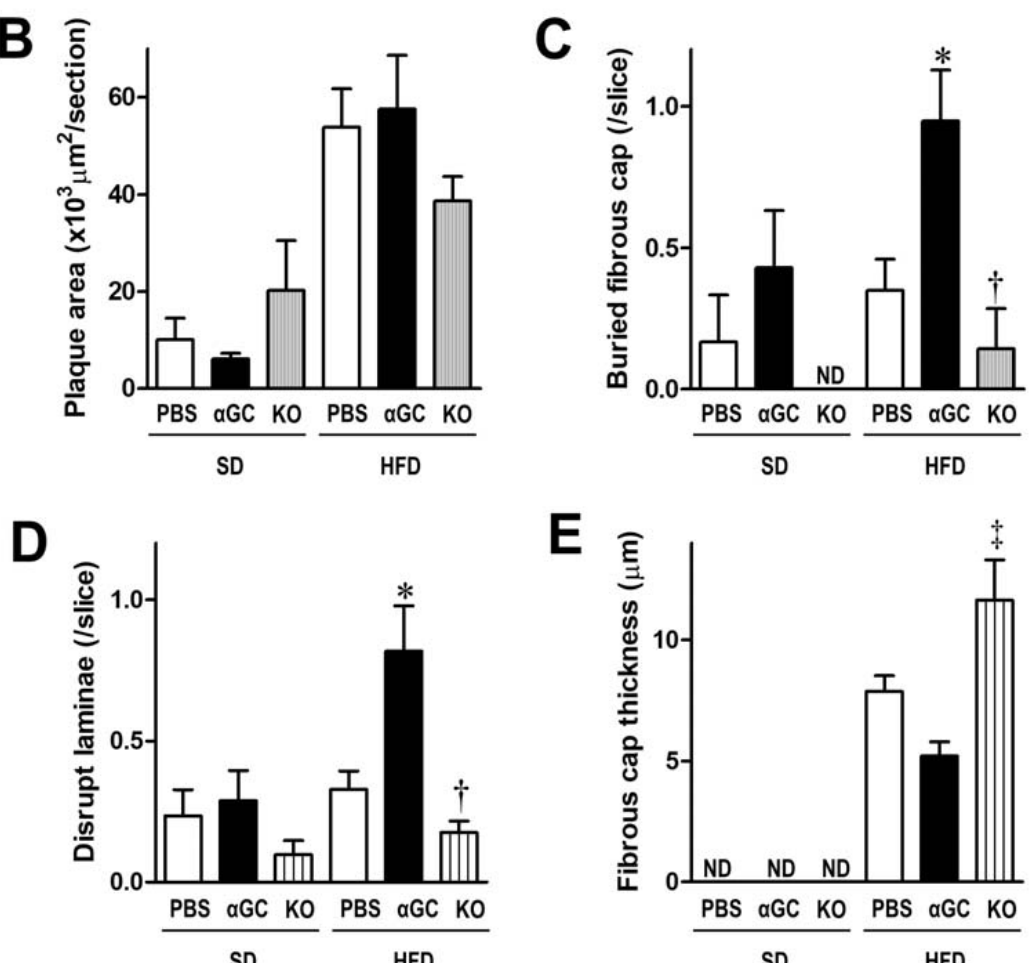
Figure 2. Histomorphometric analysis at the brachiocephalic artery from six groups of SD-PBS (n = 6), SD- α GC (n = 7), SD-KO (n = 3), HFD-PBS (n = 21), HFD- α GC (n = 21), and HFD-KO (n = 9) mice. ( A ) Representative photomicrographs of elastica-van Gieson’s staining of cross-sections. Scale bar = 100 µ m. In HFD-PBS, HFD- α GC, and HFD-KO mice, arrows indicate disrupted elastic laminae and an arrowhead indicates buried fibrous cap. Summary data of plaque area ( B ), the number of buried fibrous caps ( C ), the number of disrupted elastic-laminae ( D ), and the maximal fibrous cap thickness ( E ) from six groups of mice. * p < 0.05 vs. HFD-PBS, † p < 0.05 vs. HFD- α GC, and ‡ p < 0.01 vs. HFD- α GC by ANOVA. All data are expressed as means ± S.E. ND, not